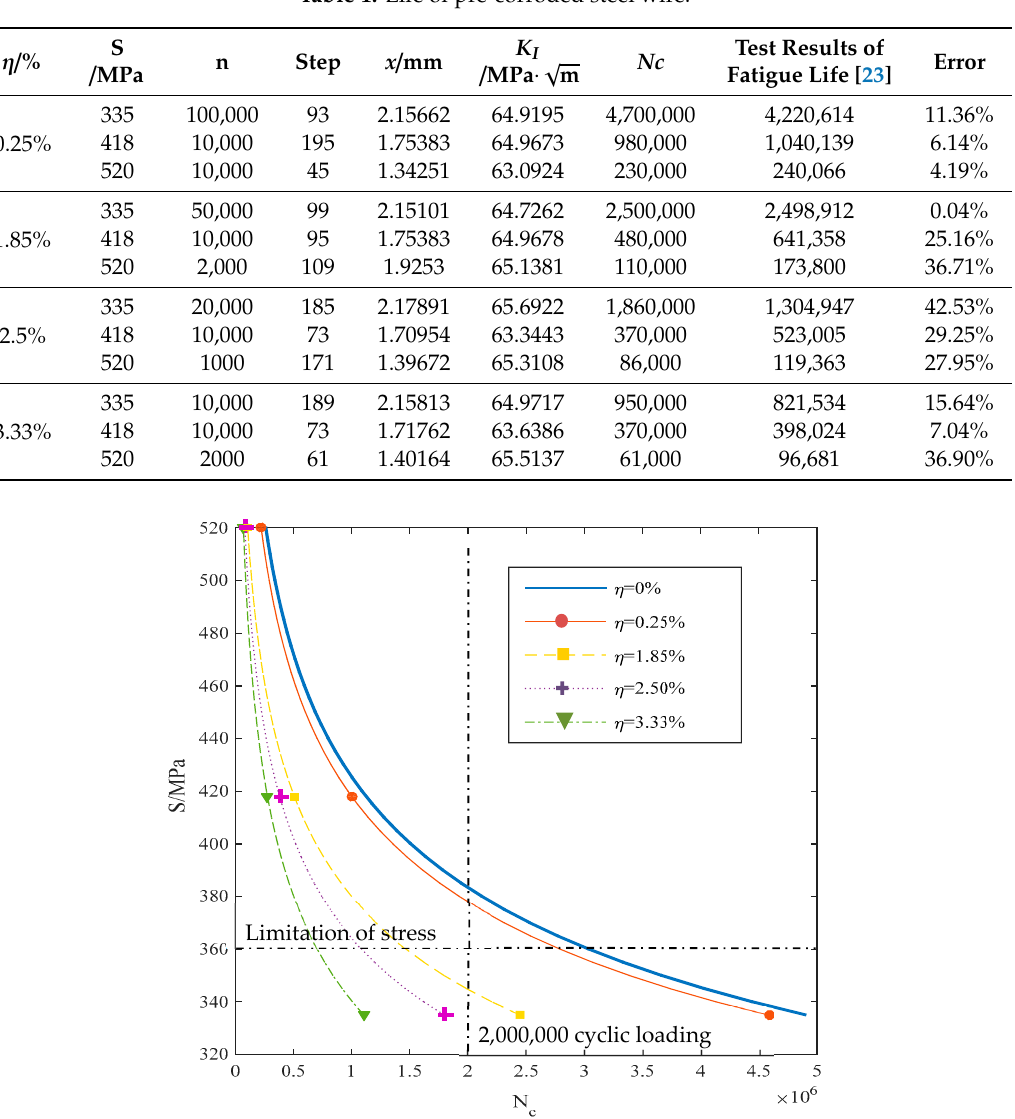
Figure 9. S-N curves of steel wires with different degrees of pre-corrosion.